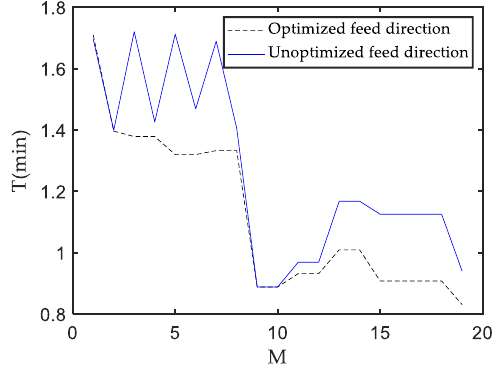
Figure 12. Cutting time.